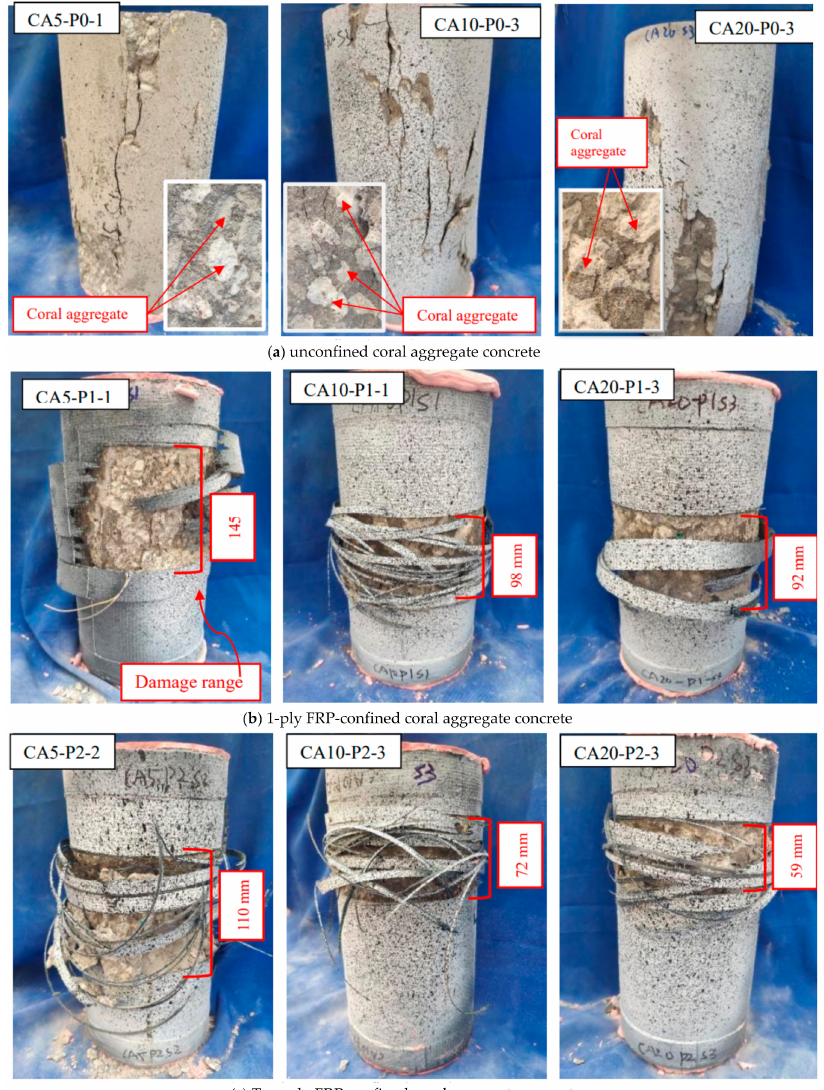
Figure 3. Failure patterns of the